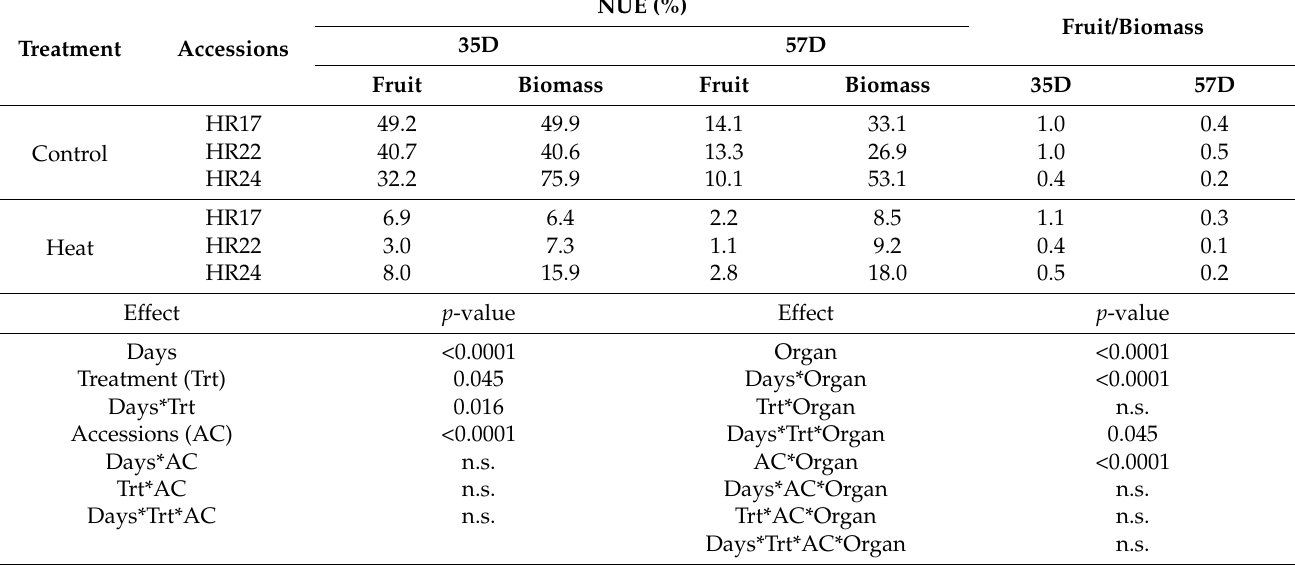
Table 5. Nitrogen Use Efficiency (NUE, %) and relative ratios of fruit and biomass NUE of three cherry tomato accessions grown in heat-treated and control greenhouses for 35 days and 57 days. ANOVA of effects of treatment days, heat stress, accessions, organs (biomass and fruit), and their interactions on NUE were presented. n.s. indicates no significant difference. * indicates the interaction between